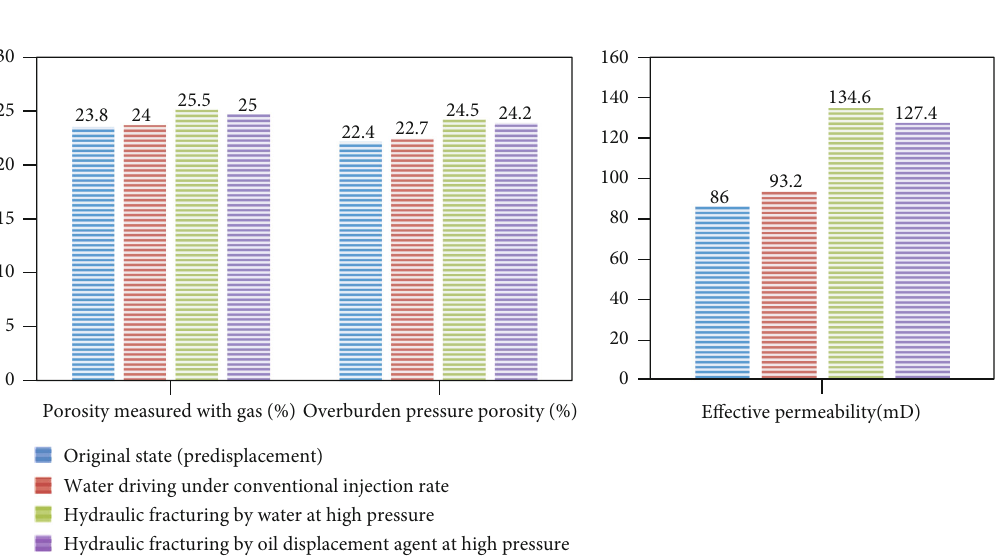
Figure 6: Results of porosity and permeability measurements of core